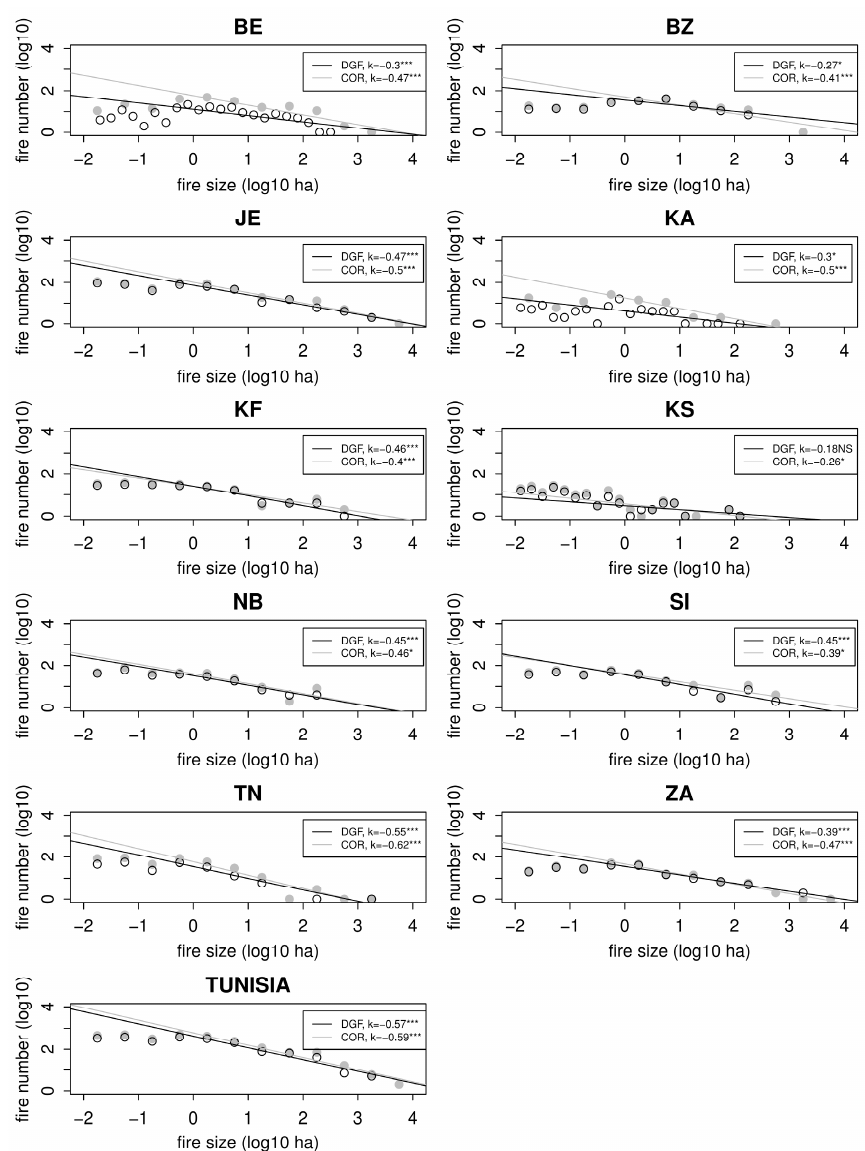
Figure 8. Fire size distribution plots for each gouvernorat and Tunisia, representing fire event number (log10 scale, Y -axis) as a function of their size ( X -axis, log10 scale). Empty black dots represent the official DGF database and the grey dots represent the corrected database COR.